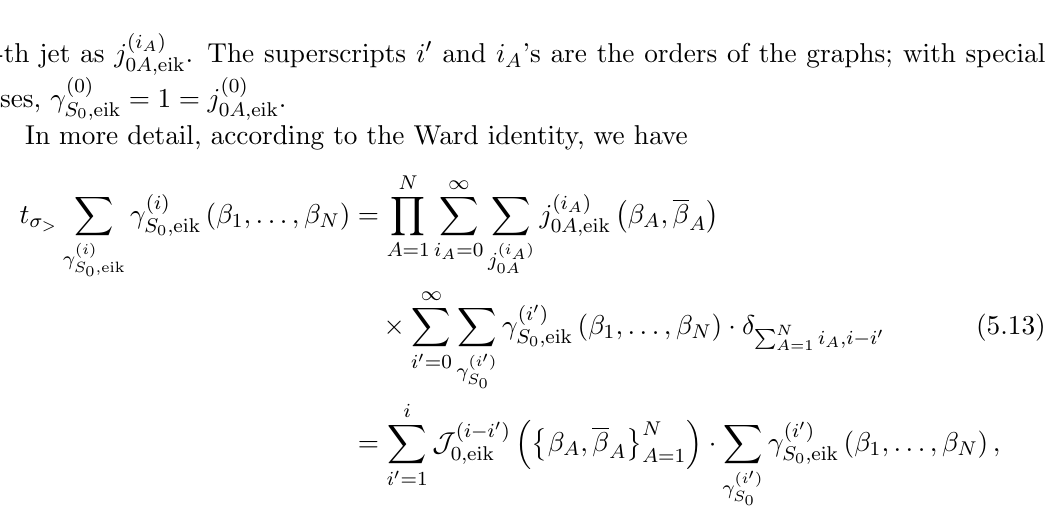
Figure 33. A pictorial illustration of (cid:13) ( i (cid:12) (cid:22) . The subgraphs (cid:13) ( i I the lower eikonal lines on both sides, whose directions are unmarked, represent the set of all the other